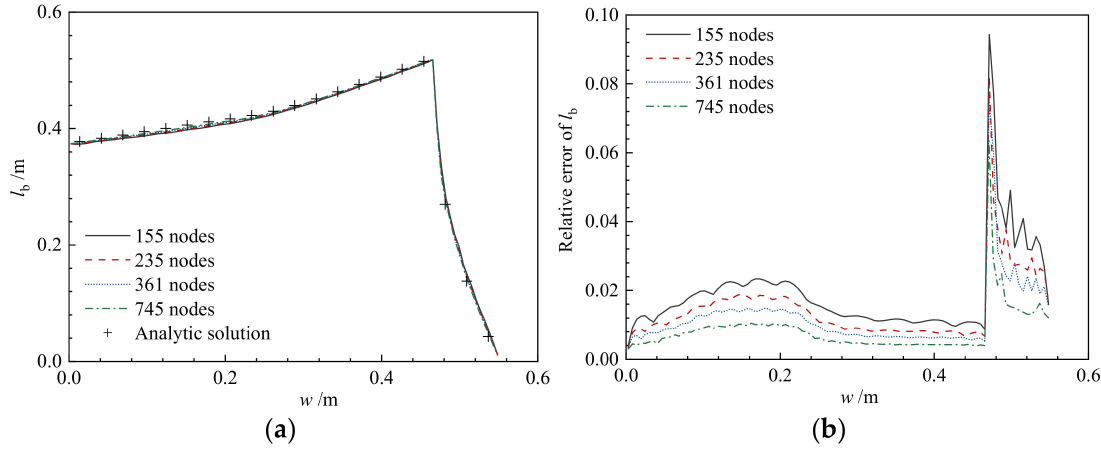
Figure 7. Results of burn perimeter for the typical star grain with different meshes: ( a ) Relation between the burn perimeter and the web thickness and ( b ) Relation between the relative error of burn perimeter and the web